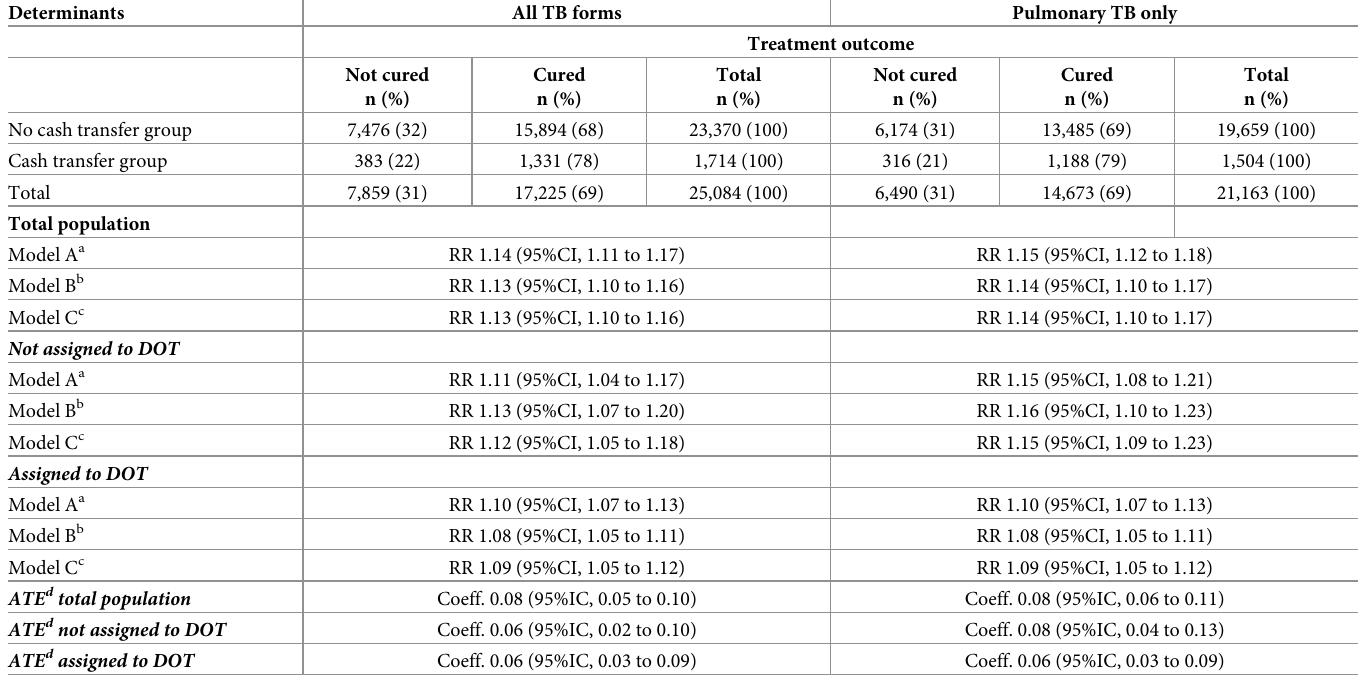
Table 4. Distribution and estimates of the direct effect of being beneficiary of governmental cash transfer program on tuberculosis treatment outcomes among peo- ple from the Brazilian Notifiable Disease Information System database (SINAN), 2015.